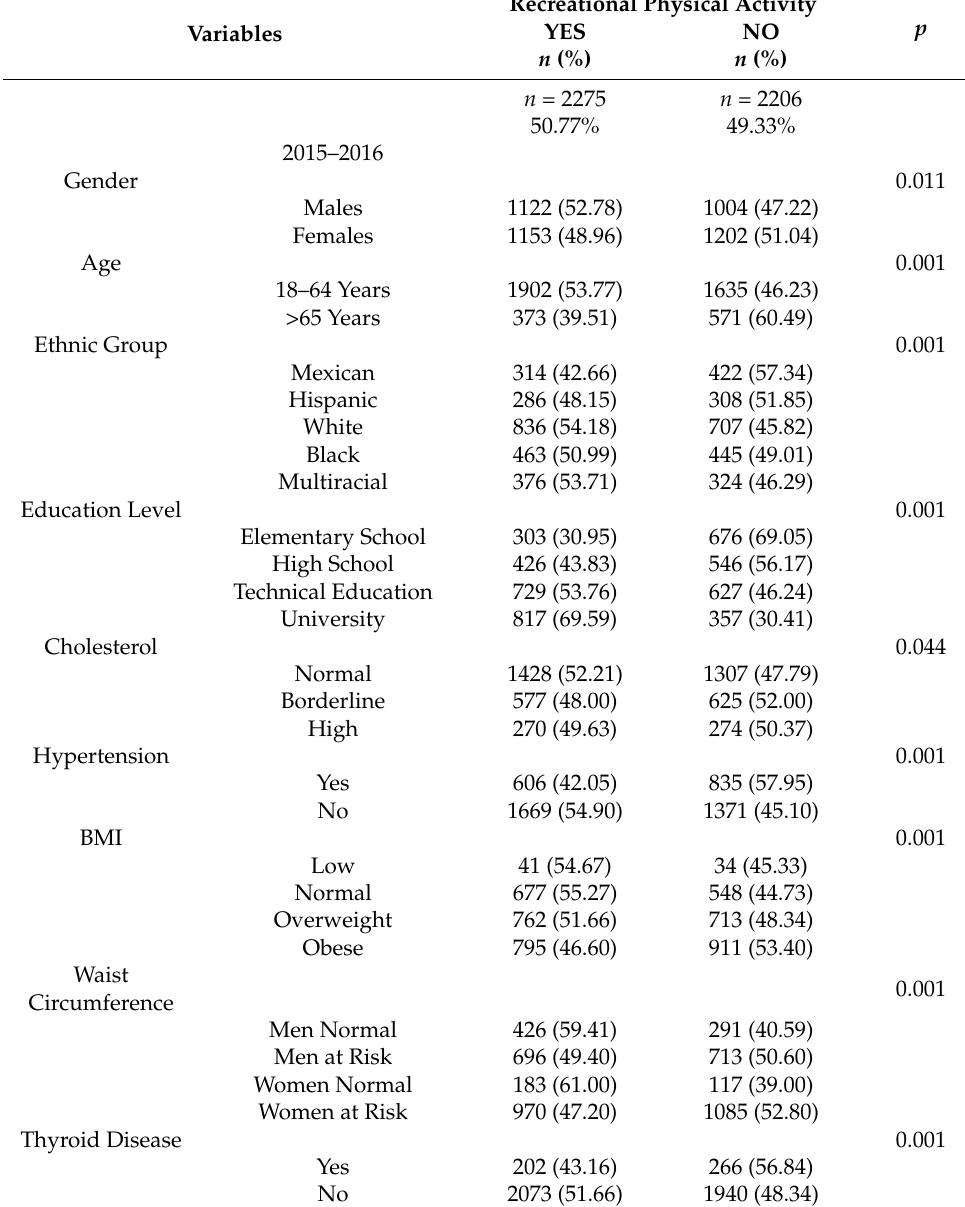
Table 2. Characteristics of recreational physical activity in U.S. adults from the NHANES